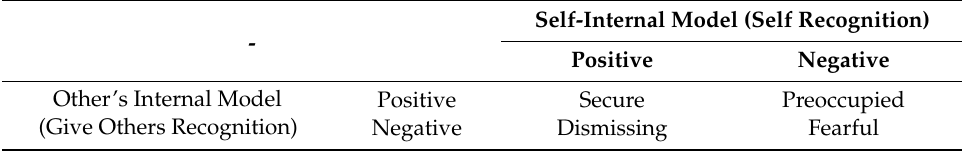
Table 1. Bartholomew and Horowitz’s four categories of adult